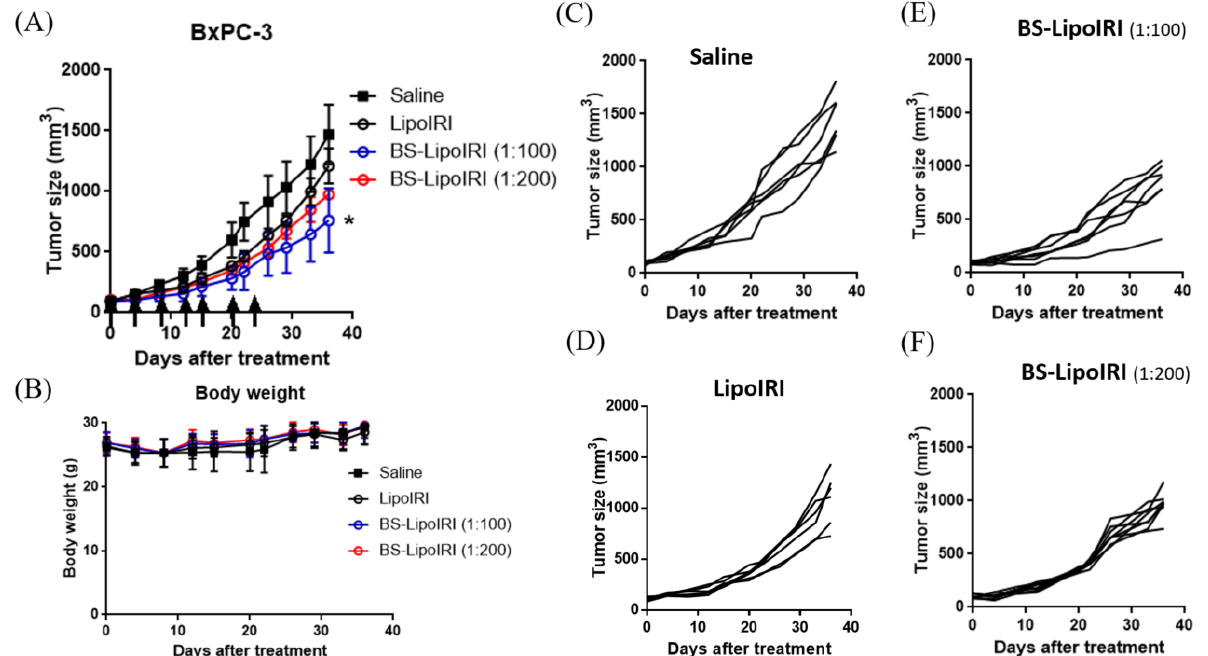
Figure 7. ( A ) The BxPC3 tumor growth curve after intravenous administration at a dosing regimen of 20 mg/kg IRI. ( B ) Body weight changes in tumor-bearing mice. Tumor size of individual mouse in the ( C ) Saline, ( D ) LipoIRI, ( E ) BS − LipoIRI (1:100), and ( F ) BS − LipoIRI (1:200) group. * p < 0.01, a statistically significant difference compared with the saline group.